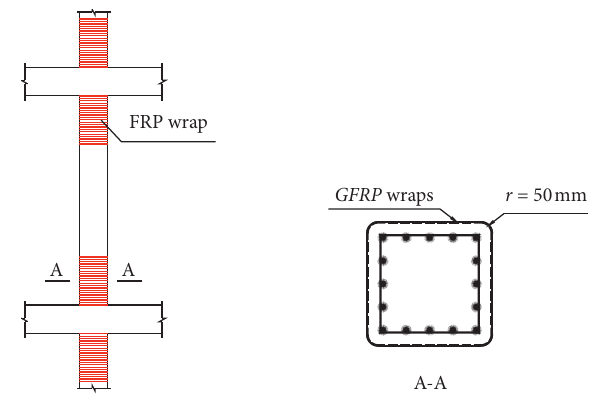
Figure 4: FRP wraps at locations of plastic